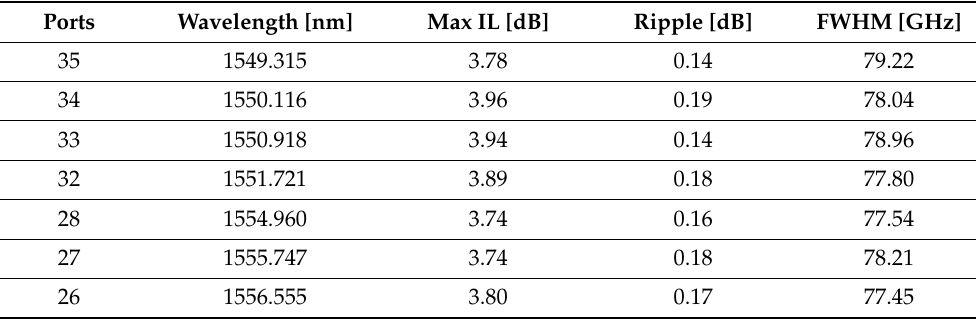
Table A1. Characteristics about AWG channels